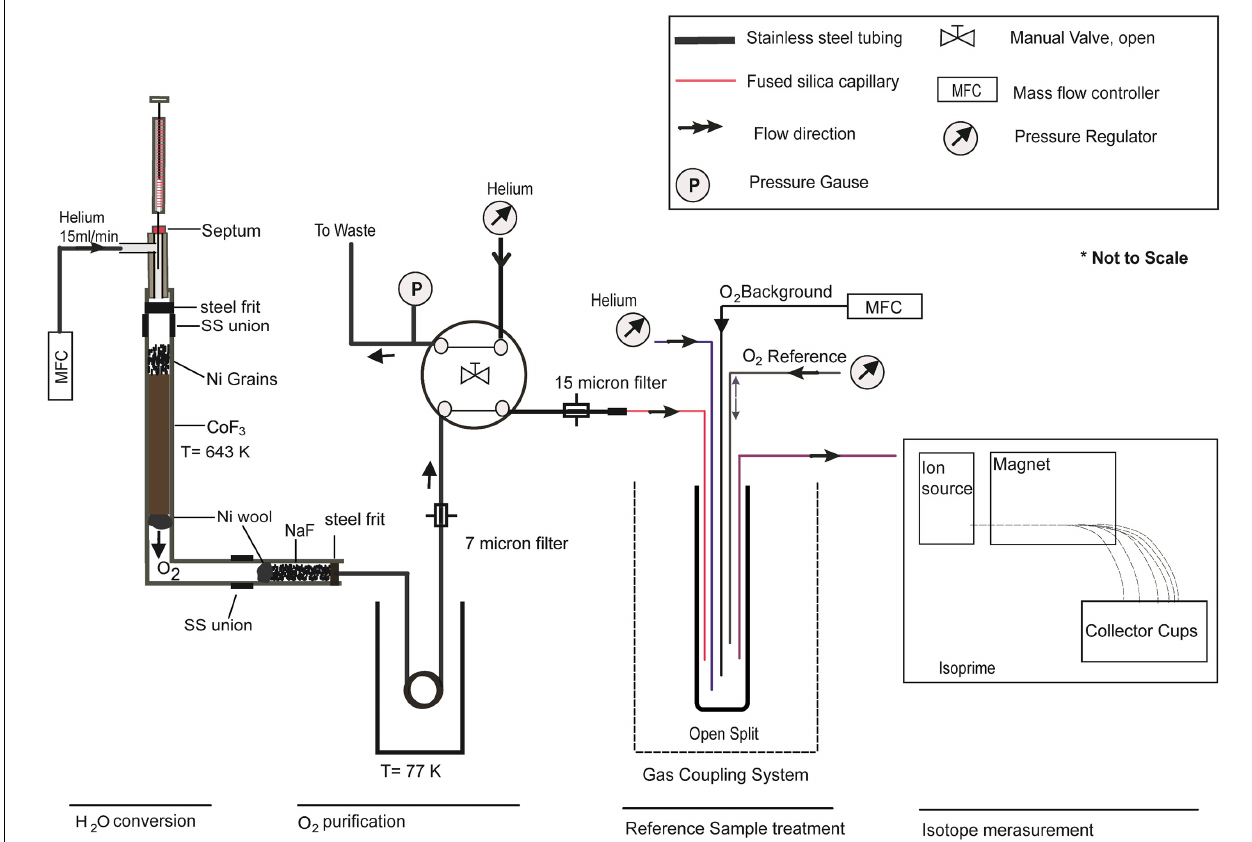
FIGURE 1 | Sketch of the continuous flow setup which has four steps (i) H 2 O conversion line, where H 2 O sample reacts with CoF 3 and is converted into O 2 gas. (ii) O 2 purification part where contaminated O 2 with its byproduct gets purified by using a cryogenic cool trap and micron size filters. (iii) Reference sample treatments part where sample and reference gases are injected on a smoothed O 2 background level. (iv) Isotope measurement part where O 2 isotopes are measured in the mass spectrometer